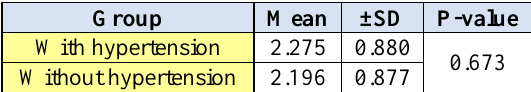
Table 2: Clinical attachment level mean and